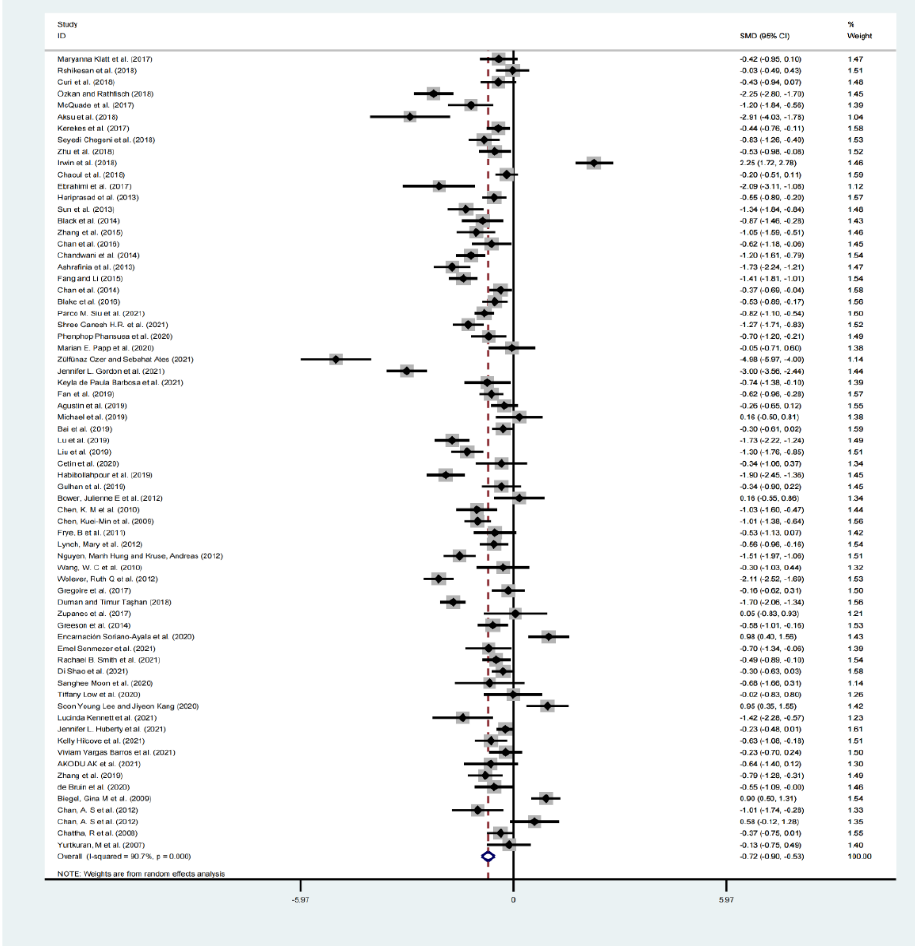
Figure 5. Forest plots of subjective outcomes in the overall analysis [12,22–84]